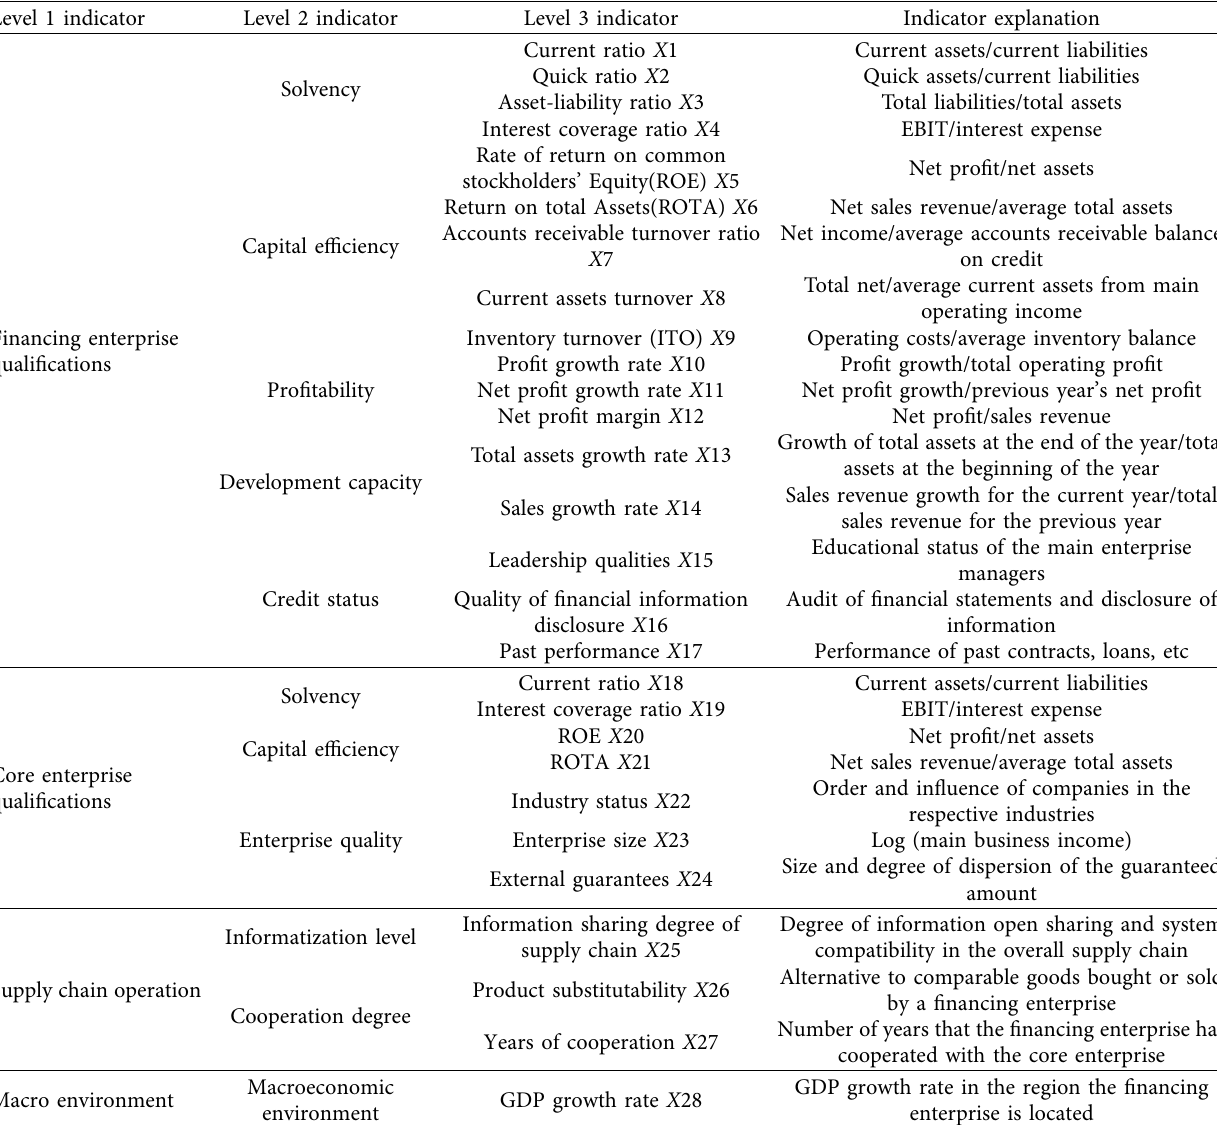
Table 1: Online supply chain fnance credit risk assessment indicator